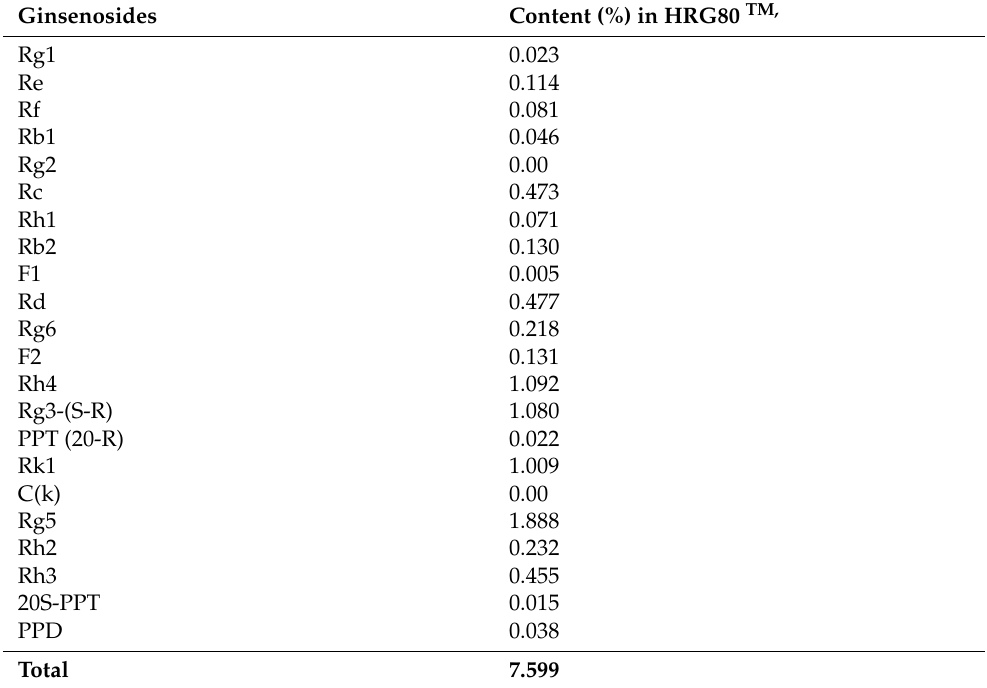
Table 9. HRG80 Red Ginseng: The composition (%) of powdered herbal